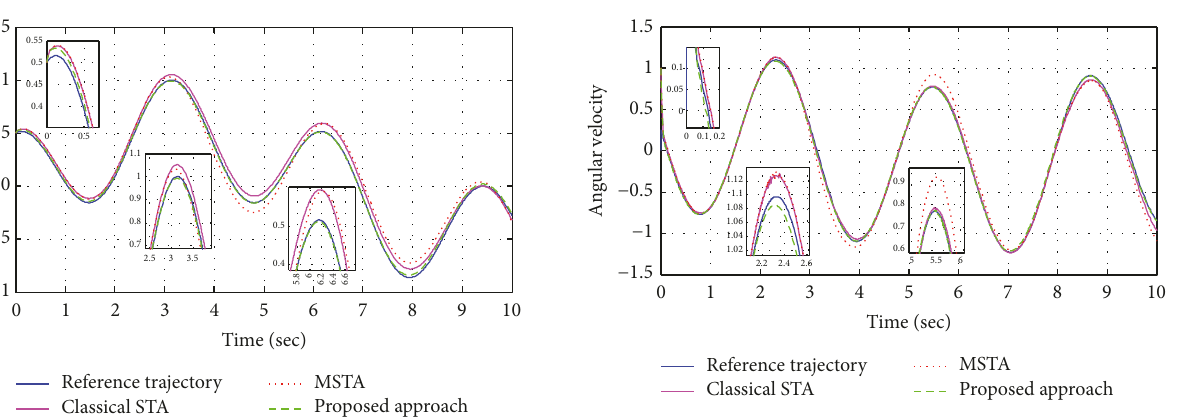
Figure 4: The response 𝑥 2 (𝑡) of the system with matched and unmatched uncertainties.